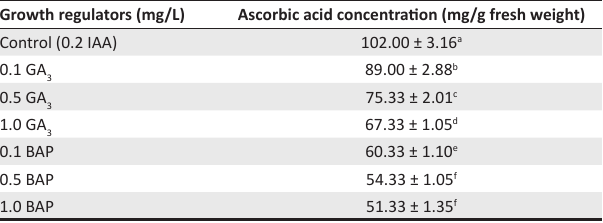
TABLE 4: Effect of different concentrations of gibberellic acid and benzyl aminopurine in combination with indole acetic acid in Murashige and Skoog medium on ascorbic acid concentration in O. gratissimum explants after 28 days of